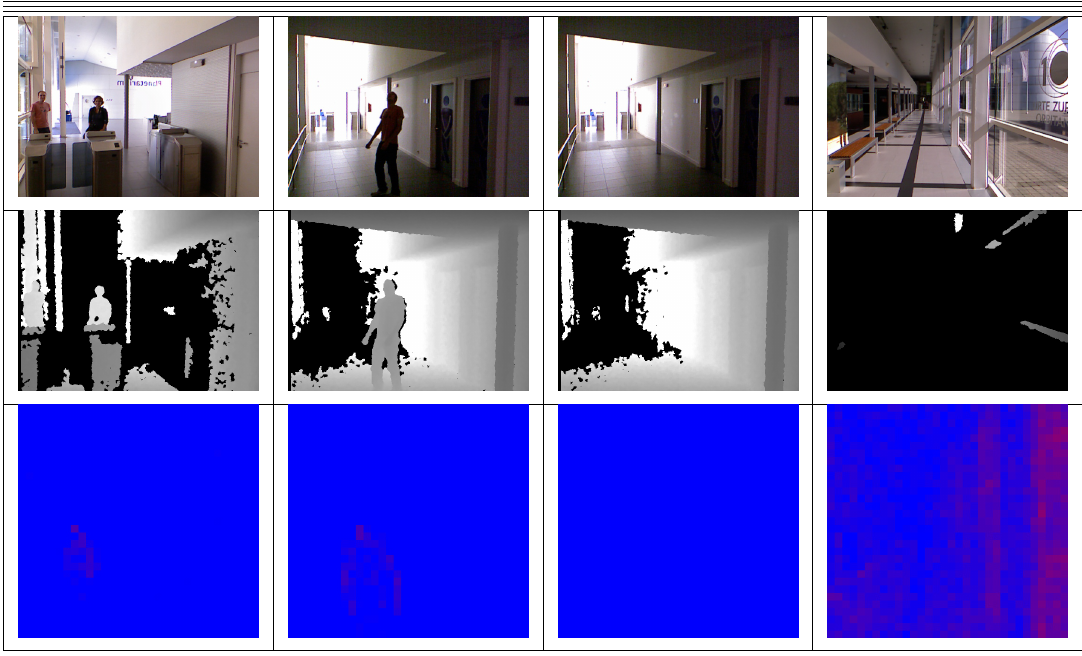
Figure 10. Images from the Eureka! Science Museum in the three data sources (intensity, depth, thermal), where different issues relevant to the problem are represented. From the left: many persons, people and objects with similar silhouettes and Sun incidence in